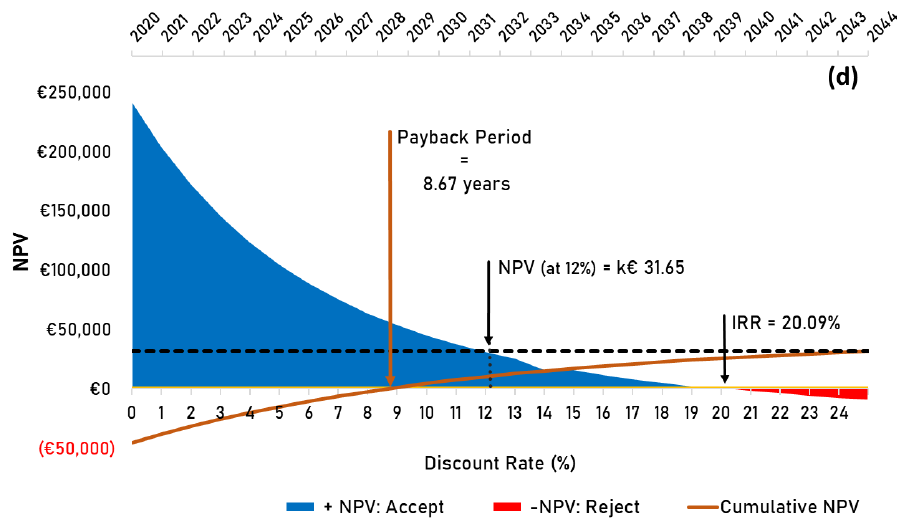
Figure 9. Financial indicators overview throughout the gasification power plant lifetime for ( a ) acacia, ( b ) MSW *, ( c ) eucalyptus and ( d ) MSW **.